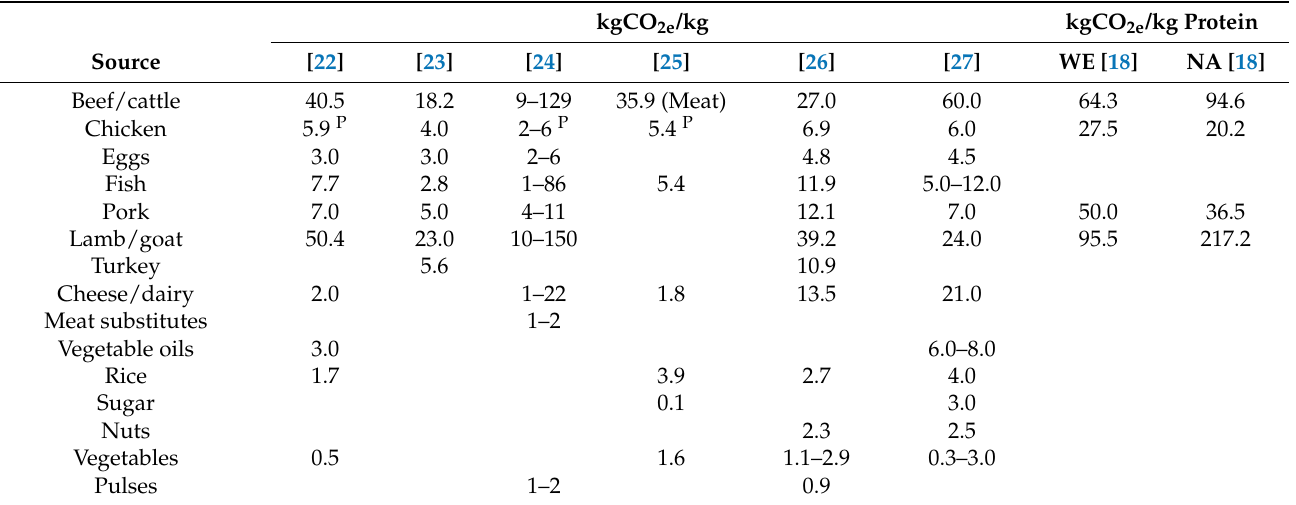
Table 2. Comparison of emissions factors by weight and by protein weight for meat and food products from different